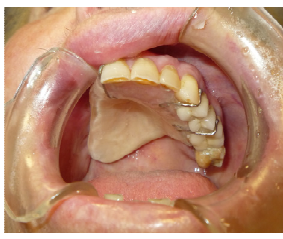
Figure 5. Palatal plate.